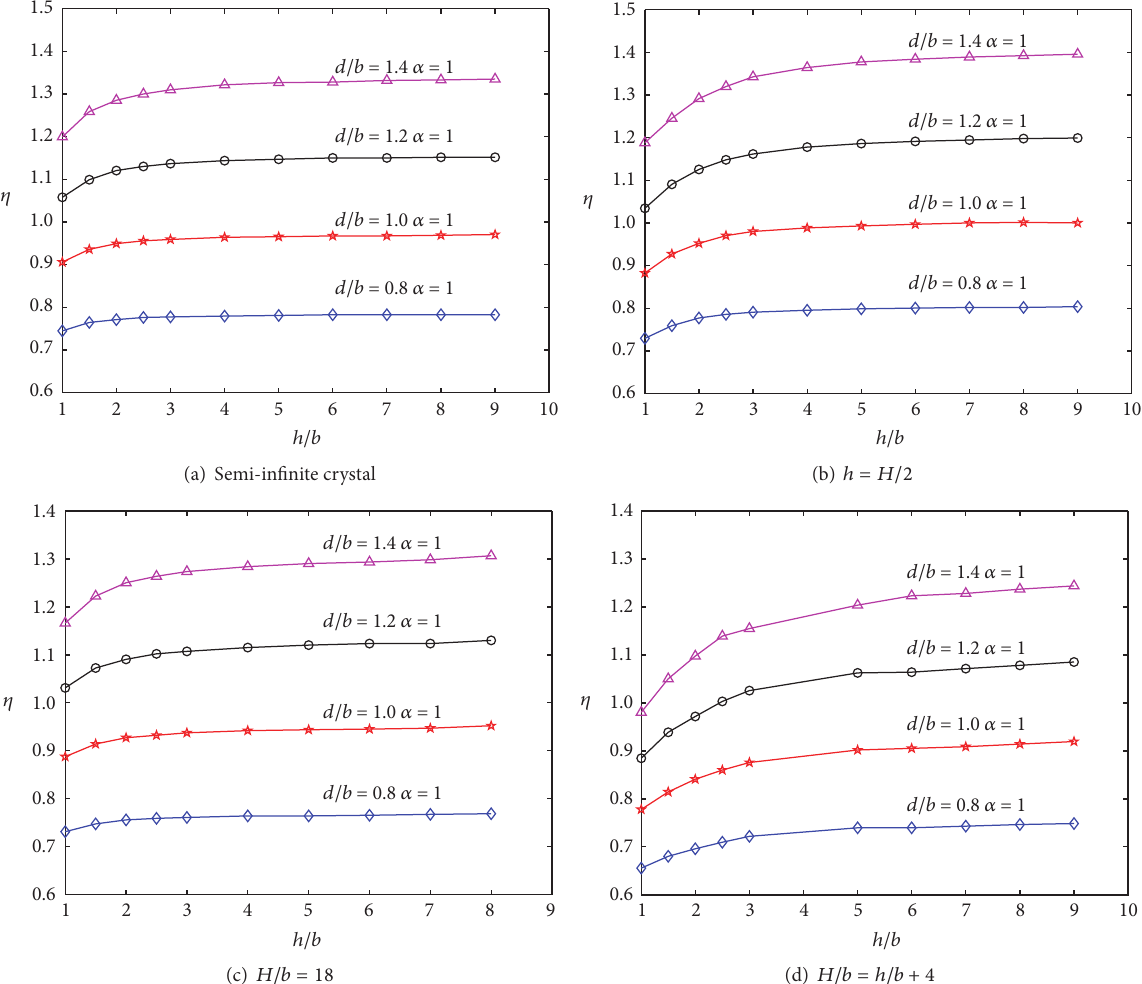
Figure 3: Variation of core structure parameter 𝜂 with respect to the dislocation’s distance to the surface for various interplanar atomistic spacing ( 𝑑/𝑏 ) for screw dislocations.